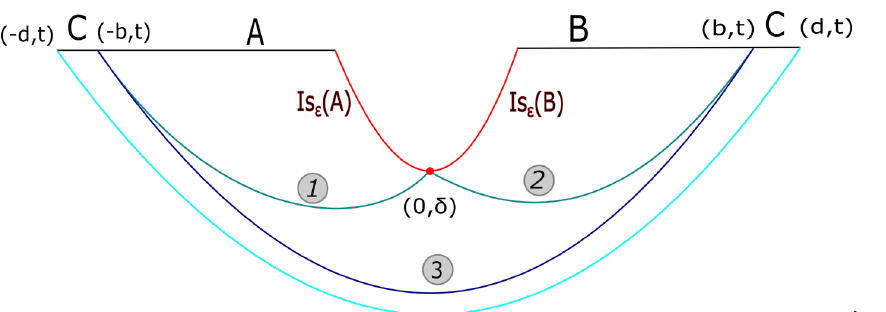
Figure 21: Schematic of the island proposal-I for the entanglement negativity of